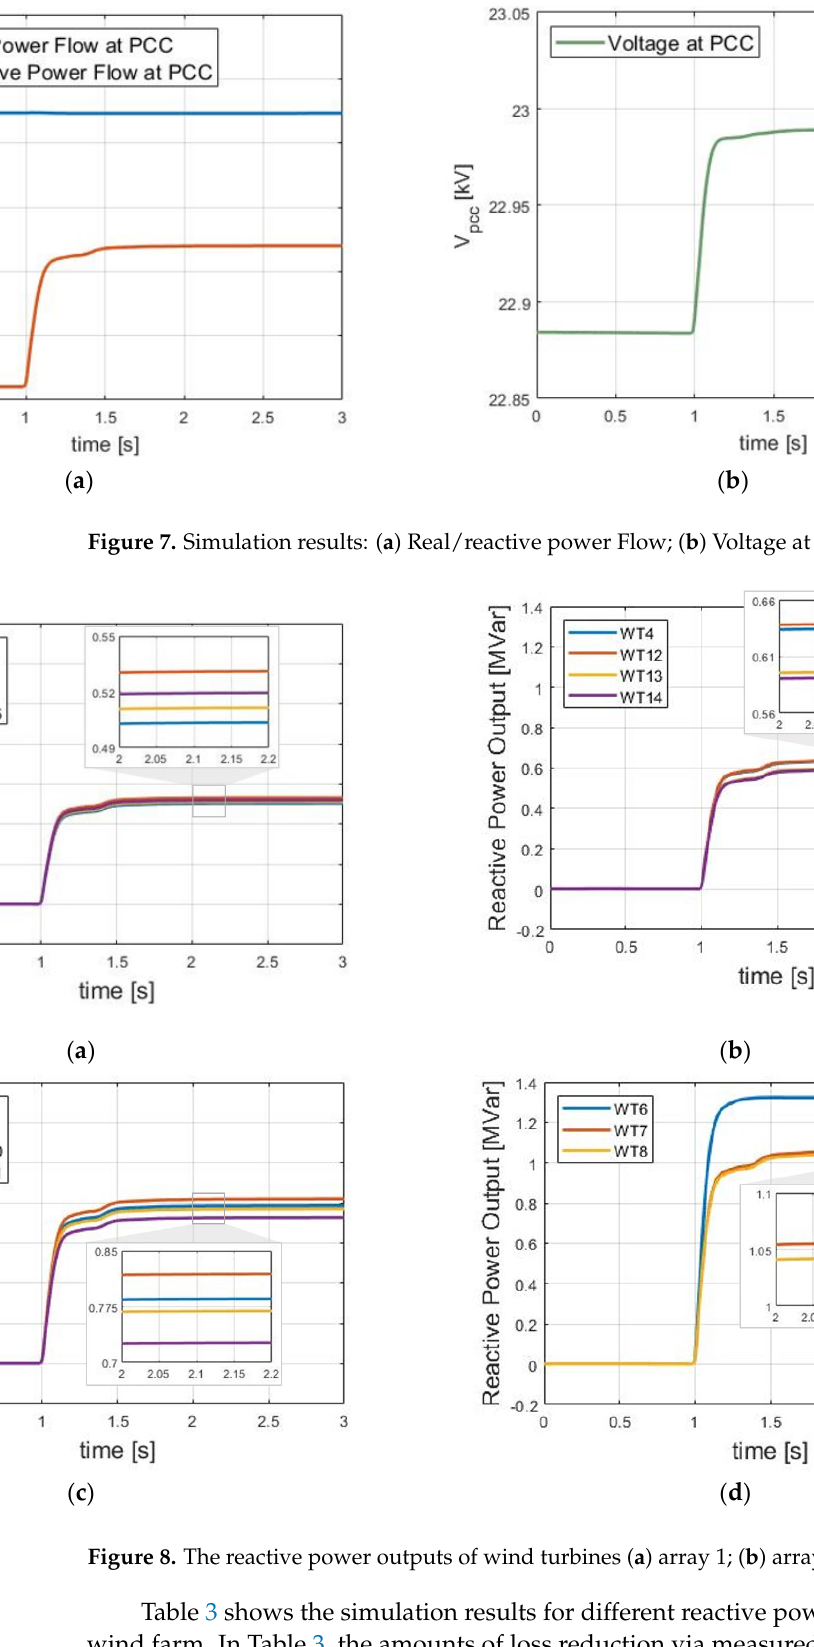
Table 3. Average real power prof i les and reduced power loss.